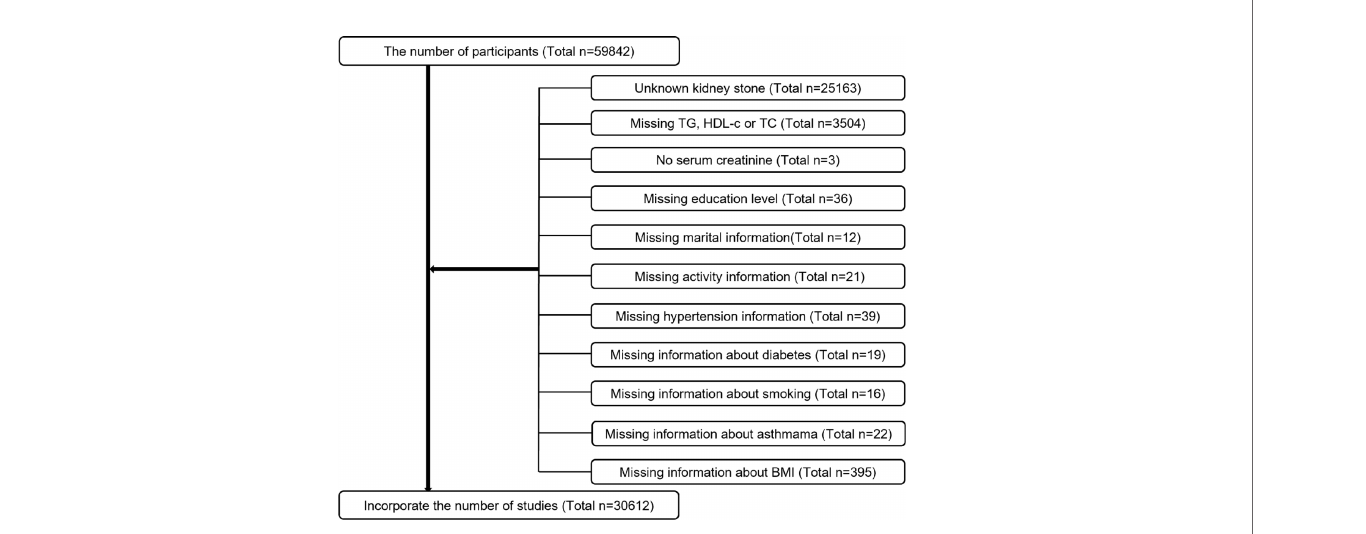
FIGURE 1 | Sample selection fl owchart from NHANES 2007 –